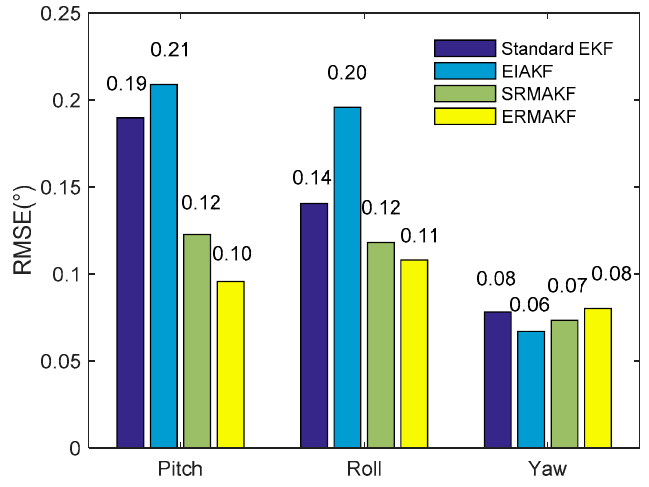
Figure 10. Comparison of attitude RMSE for different algorithms.